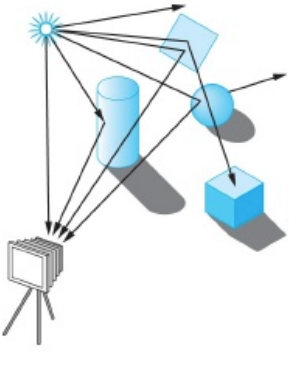
Fig. 2. Rays of light from a point